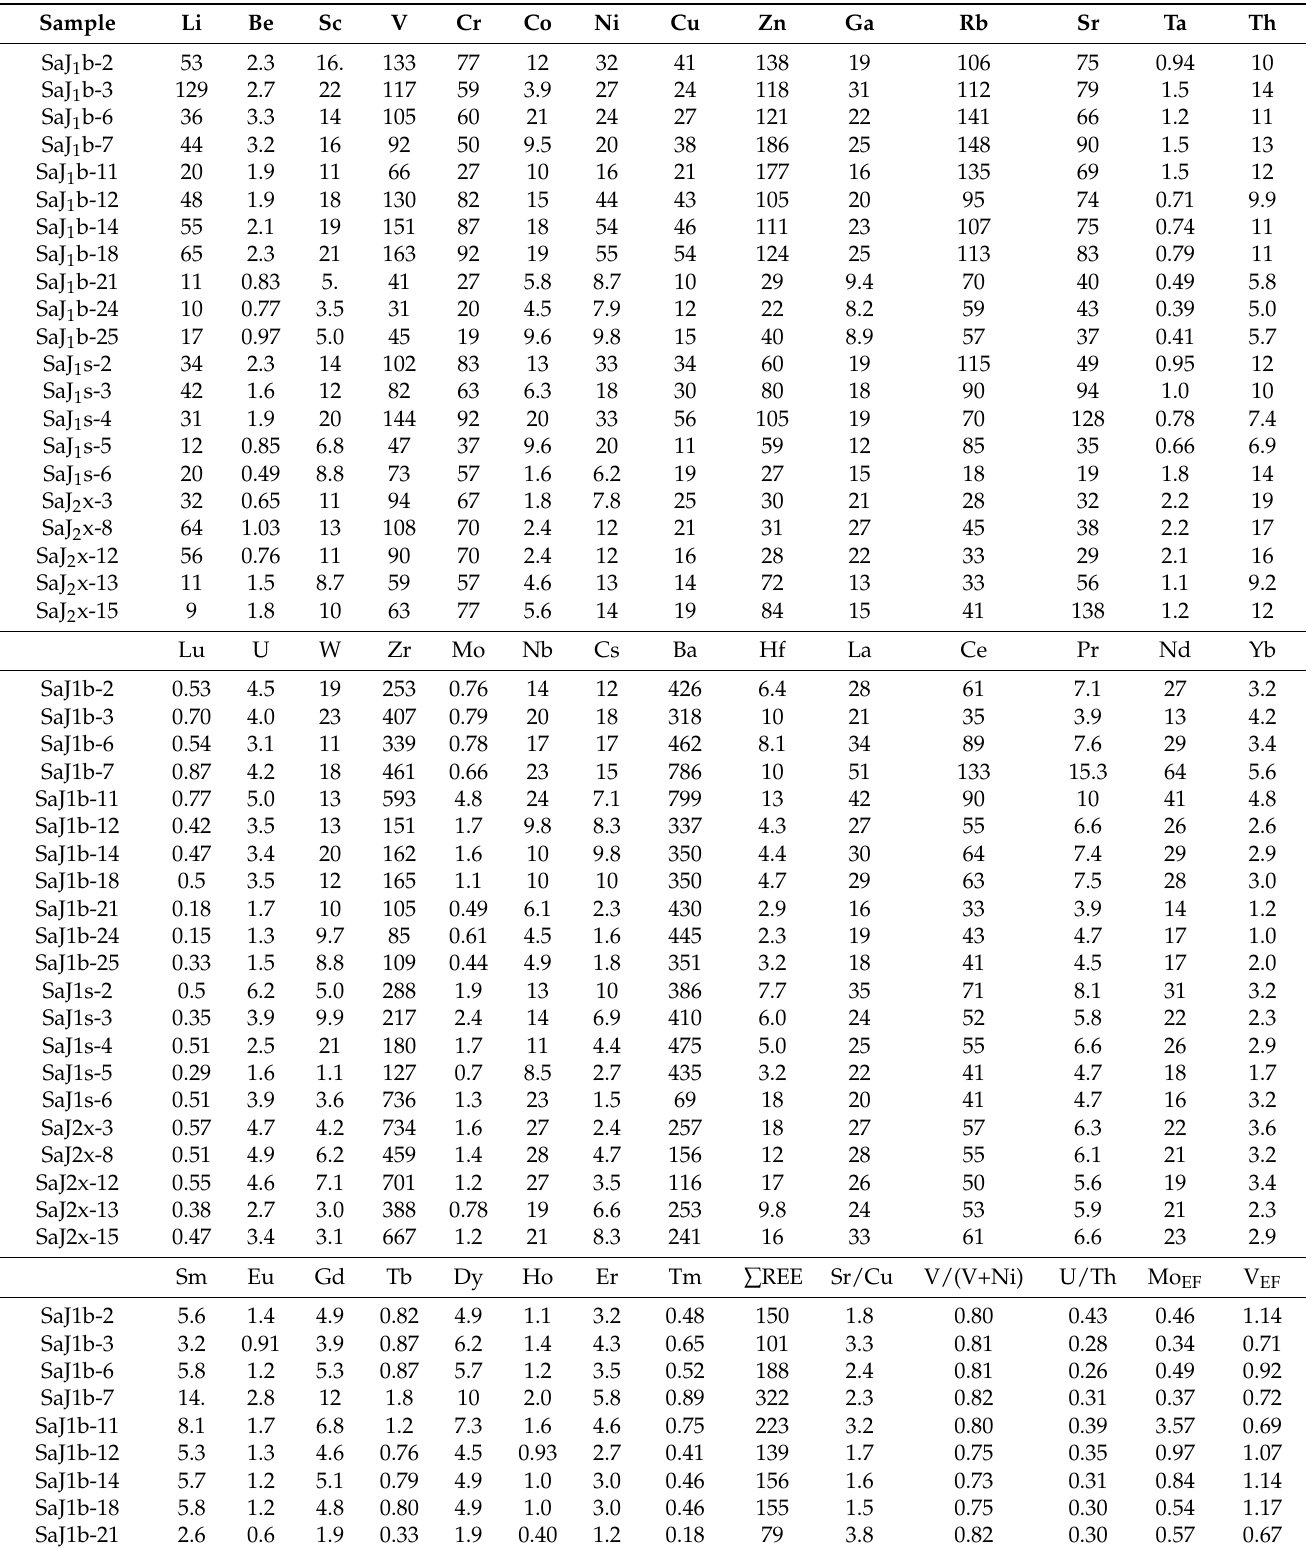
Table 1. Trace element and rare earth element contents (ppm) of samples from the Su’asugou section in Yili Basin, NW